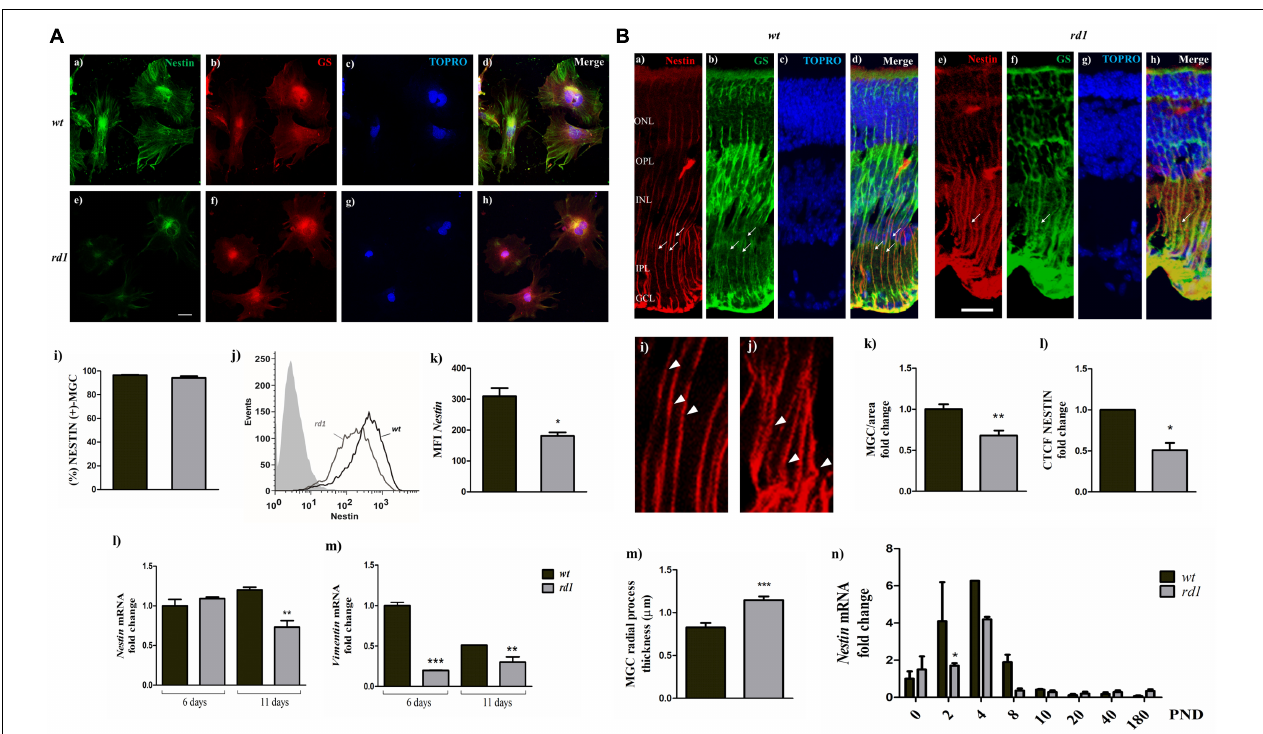
FIGURE 4 | Nestin expression decreased in rd1 retinas. Panel (A) fluorescence photomicrographs of 11-day wt (a–d) and rd1 (e–h) mixed neuron-glial cultures showing NESTIN (a,e) ; GS (b,f) and TOPRO-3 (c,g) labeling. Merge pictures are shown in (d,h) . Bars in (i) depict the percentage of NESTIN-expressing MGC, determined by flow cytometry. The histogram (j) shows the distribution of the intensity of NESTIN expression in MGC and bars in (k) show the medium fluorescence intensity of NESTIN labeling in wt and rd1 MGC. Bars represent the fold-change in Nestin (l) and Vimentin mRNA levels (m) in rd1 and wt cultures, relative to their levels in wt cultures at day 6. Scale bar: 40 µ m. Results represent the mean ± SEM of three experiments ( n = 3). Panel (B) Fluorescence photomicrographs of wt (a–d) and rd1 (e–h) PND 14 retina cryosections showing MGC labeling with NESTIN (a,e) and GS (b,f) ; MGC projections are indicated with thin arrows. Nuclei were stained with TOPRO-3 (c,g) . Merge pictures are shown in (d,h) . Confocal optical sections of retinas show the regular nestin filament distribution in MGC radial processes in wt retinas ( i , arrowheads) and the conspicuous thickening and disorganization of radial processes at their basal ends in the rd1 retinas ( j , arrowheads). Bars in (k) show the fold change in the number of NESTIN-expressing MGC per area. Bars (l) depict the Corrected Total Cell Fluorescence (CTCF) as Integrated Density − (Area of selected cells x Mean fluorescence of background readings, analyzed after manually outlining regions of interest (ROI) with the software Fiji-Image J (see section “Materials and Methods”). Bars in (m) depict the thickness of MGC radial processes in wt and rd1 retinas [shown with thin arrows in Panel (B) a,b,d,e,f,h ; arrowheads in i,j ]. Bars in (n) represent the fold changes in Nestin mRNA levels at PND 0-180 in rd1 and wt mice retinas relative to their levels at PND 0 in wt retinas. Scale bar: 20 µ m. Results in k–m represents the mean ± SEM of ten separate measures. Results in (n) represent the mean ± SEM of three mice per condition at each PND day analyzed. Statistical analysis was performed using a two-tailed Student t -test [Panels (A) i,k and (B) k–m] and a One-way ANOVA with